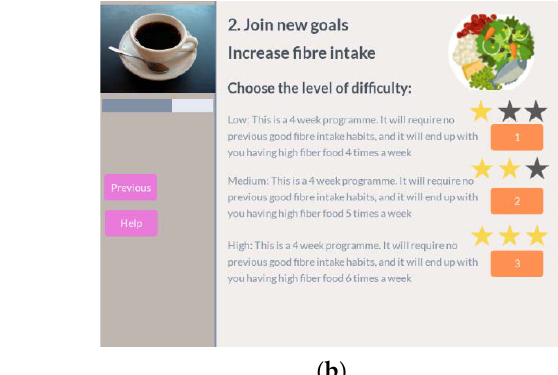
( b ) Figure 14. Join goal in coffee session. ( a ) Plan summary and confirmation; ( b ) confirmation and motivational message. After finishing the goal review and join steps, the participant can have a preview of the overall target activities that will be scheduled the next week for all goals he has joined. He will then receive a reminder to have another coffee session next week (Figure 15).